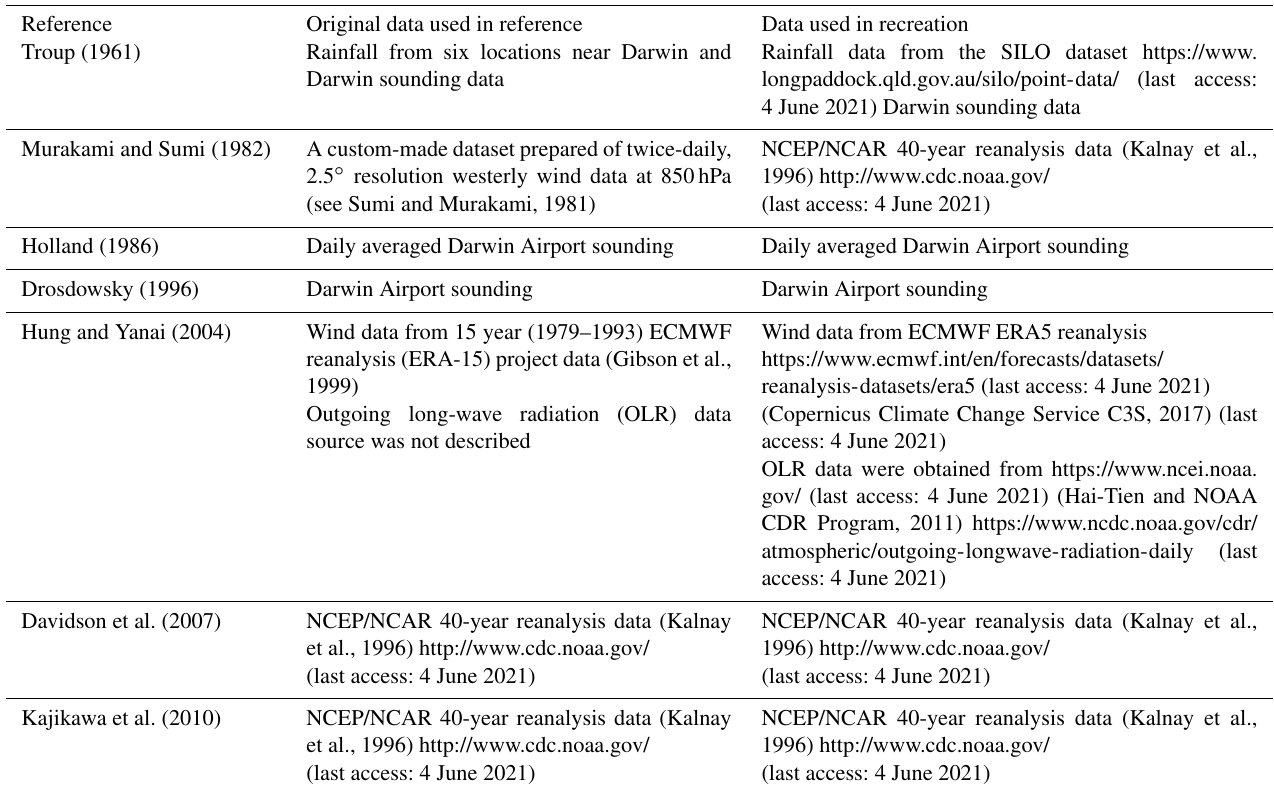
Table 1. Data used to calculate Australian monsoon onset dates. The web links listed in the table were valid as of the date this work was